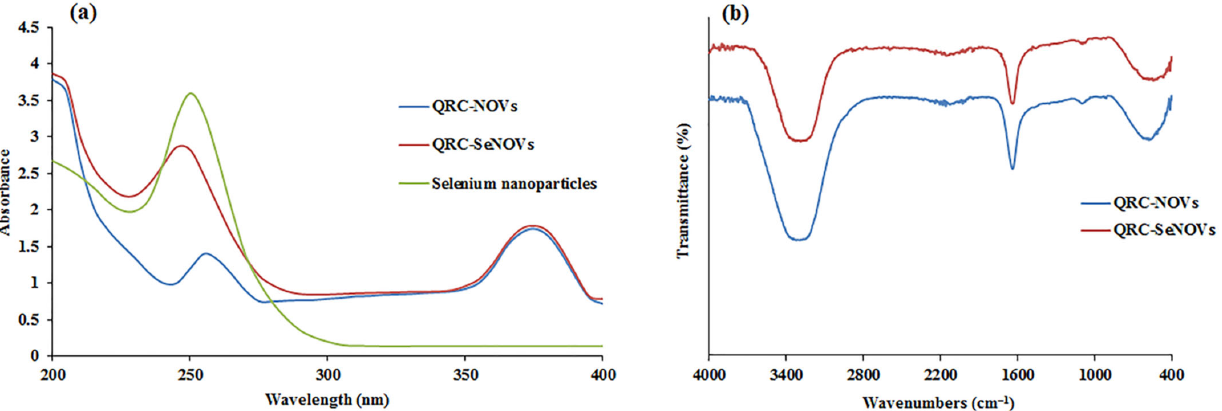
Figure 2. ( a ) UV–Vis spectra of QRC-NOVs, QRC-SeNOVs, and selenium nanoparticles; ( b ) FT-IR spectra of QRC-NOVs, and